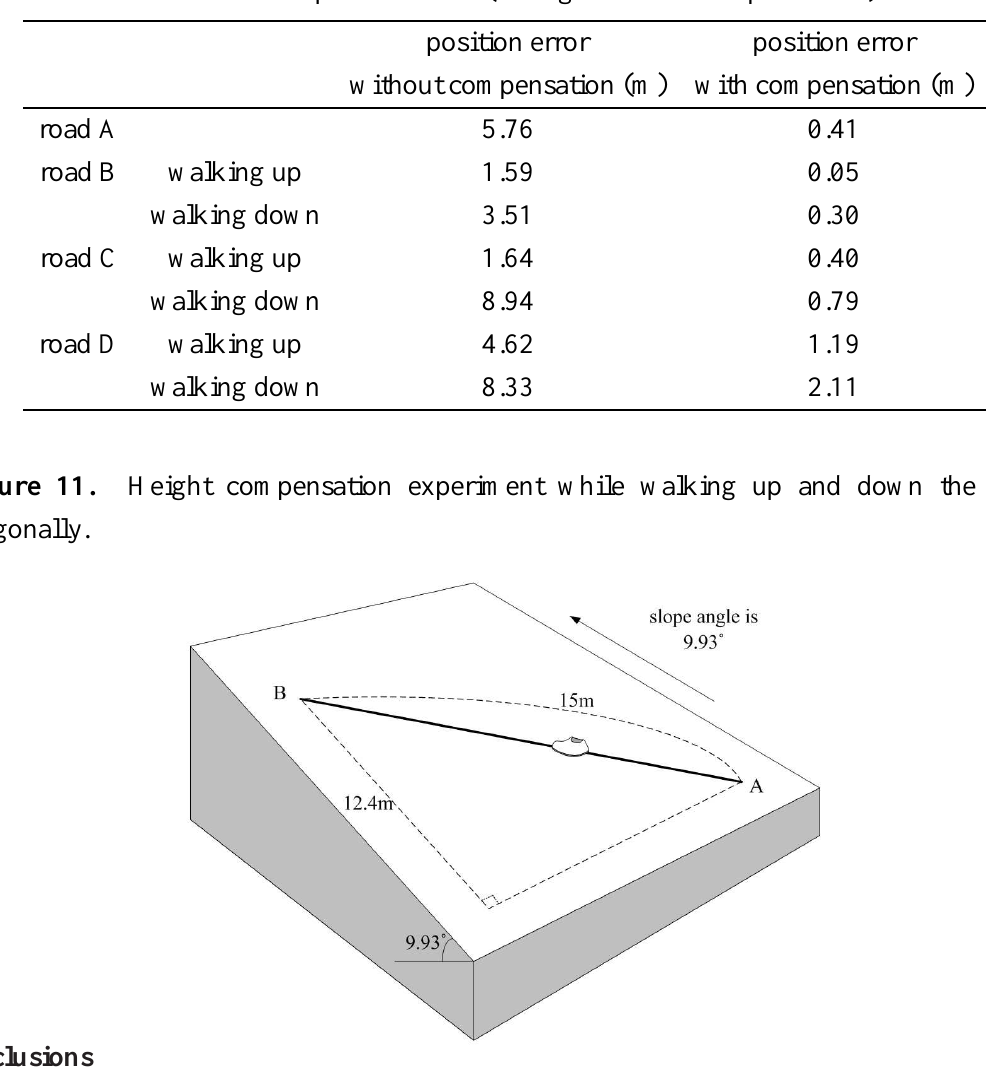
Table 2. z axis position error (average value of 3 experiments).